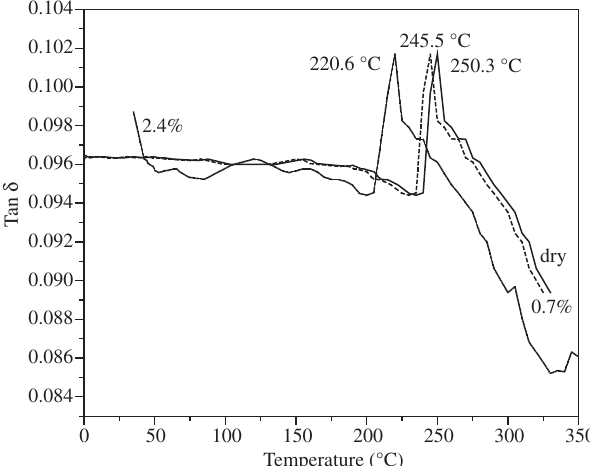
Figure 2. Tan delta ( δ ) as function of temperature of dry and wet carbon/bis- maleimide